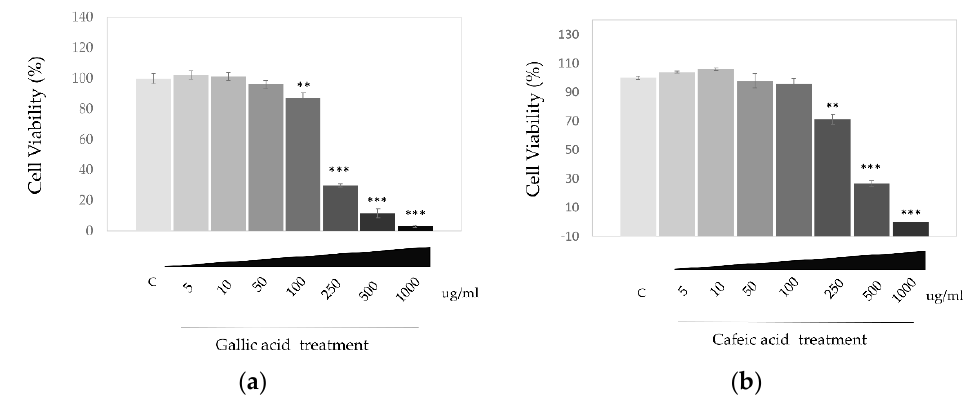
Figure 3. Cytotoxicity effect of gallic and caffeic acid on SK-HEP-1 cell line. ( a ) The effect of different concentrations of gallic acid ( b ) The effect of different concentrations of caffeic acid. (** p < 0.001, *** p <